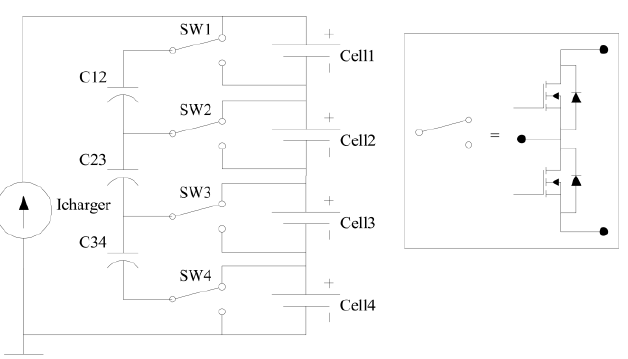
Fig. 3. Switch Capacitor method.